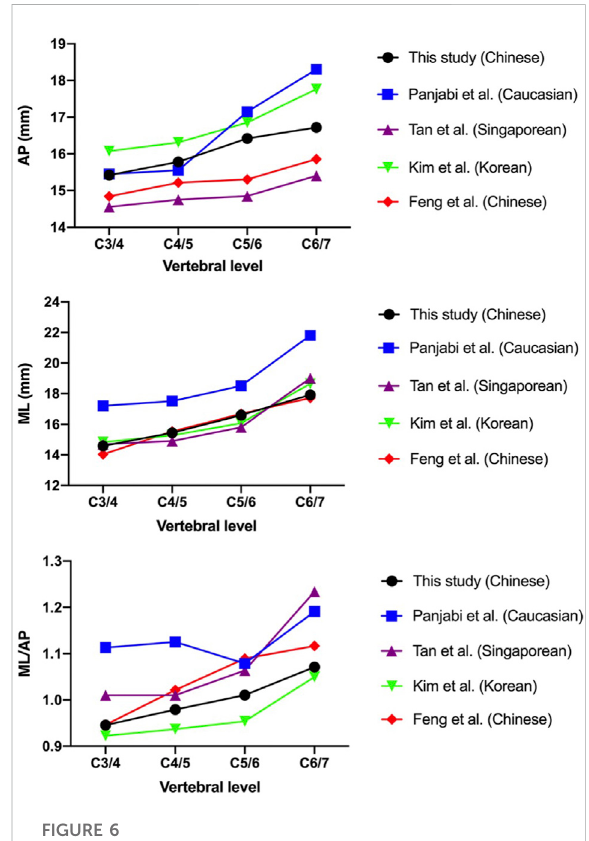
FIGURE 6 Comparison of the measurements of the present study with those reported by previous